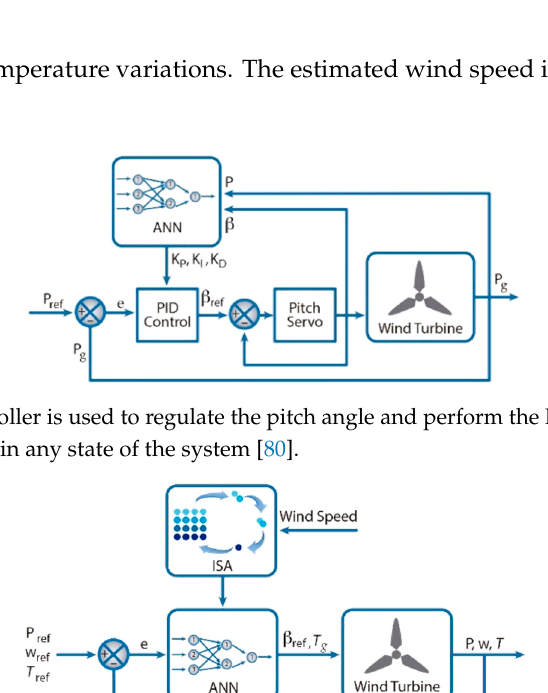
Figure 20. In control systems, ISO algorithms are used to train an ANN with greater speed, the purpose of the ANN is varied, and in this case, the reference of the pitch angle and generator torque is obtained [81].